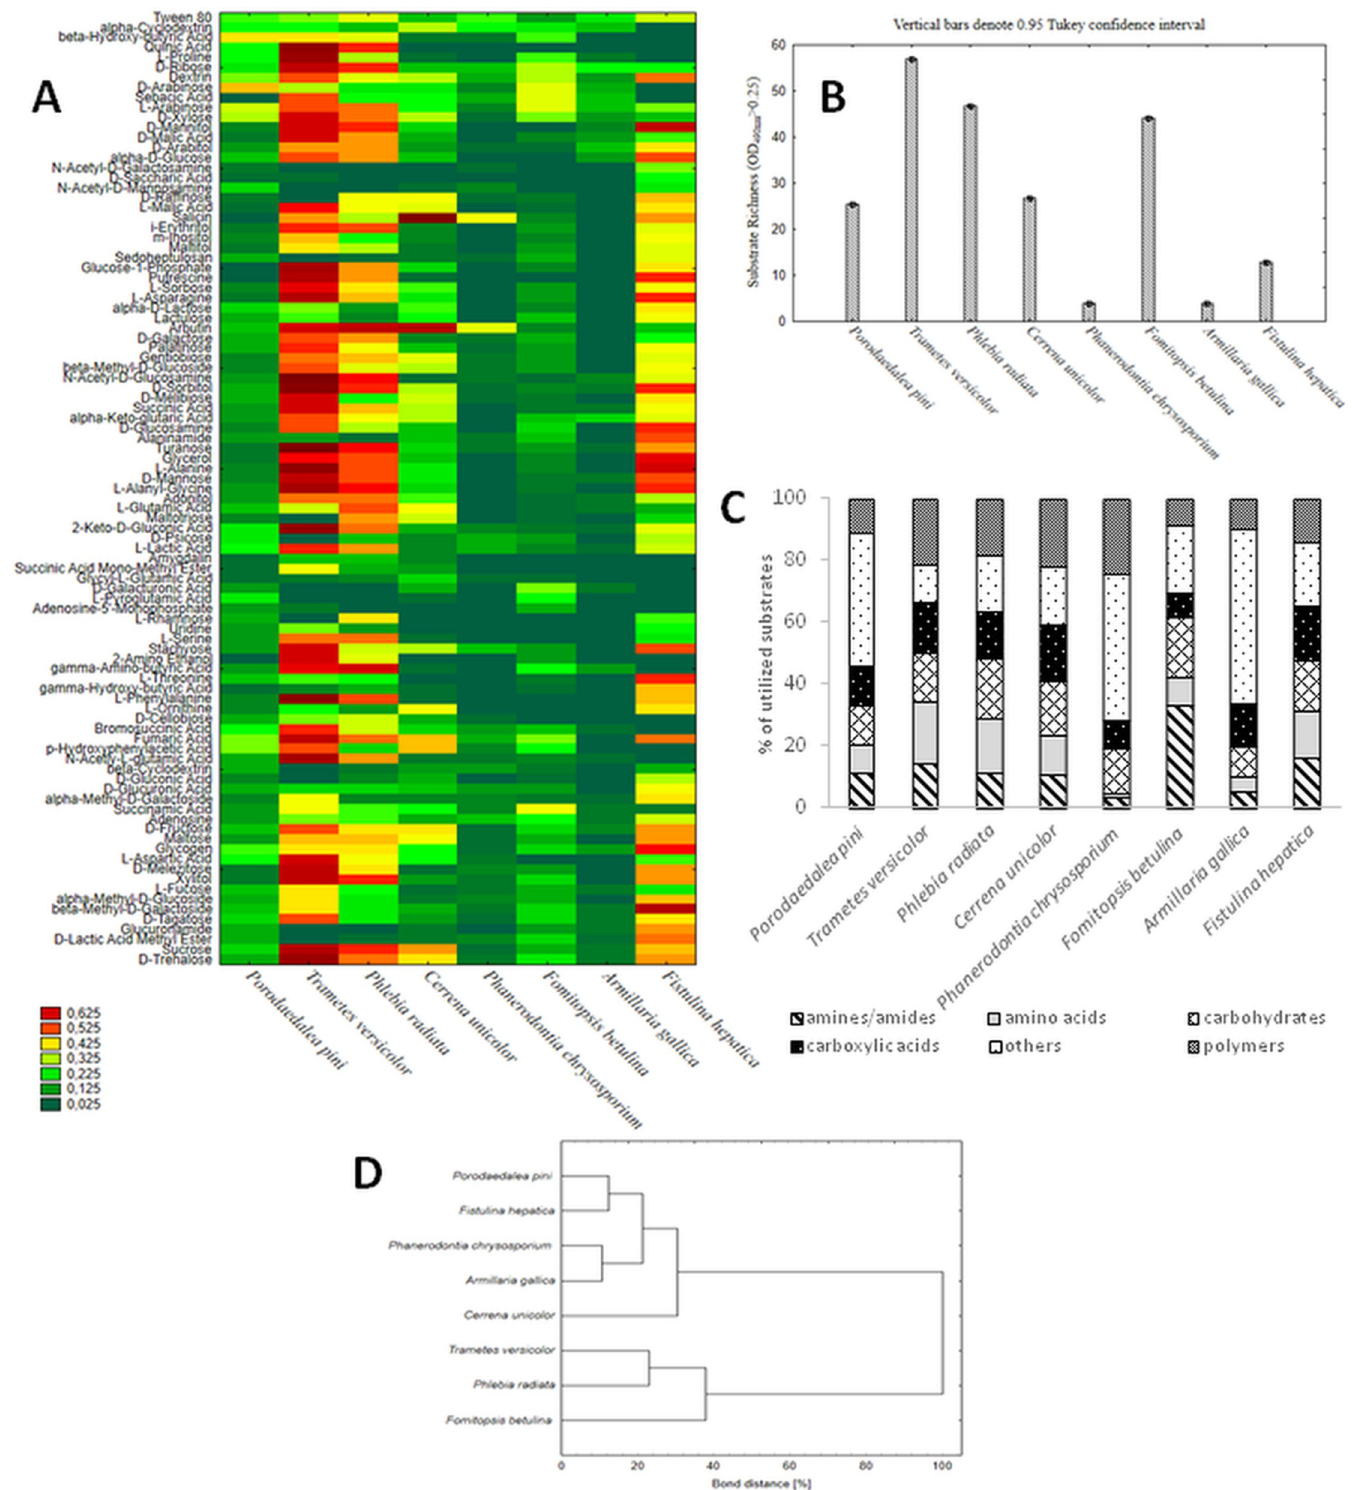
Fig 1. Comparison of metabolic aptitudes of different wood-rotting fungi. (A) Phenotype profiles of P . pini FCL3, T . versicolor FCL7, P . radiata FCL99, C . unicolor FCL139, P . chrysosporium FCL236, F . betulina FCL397, A . gallica FCL400, and F . hepatica FCL457 determined by Biolog FF MicroPlates during 192 hours of incubation with respective substrates. The color scale applied into the heat maps indicates the growth of the fungus (mitochondrial activity A 490nm ) on a particular substrate. (B)